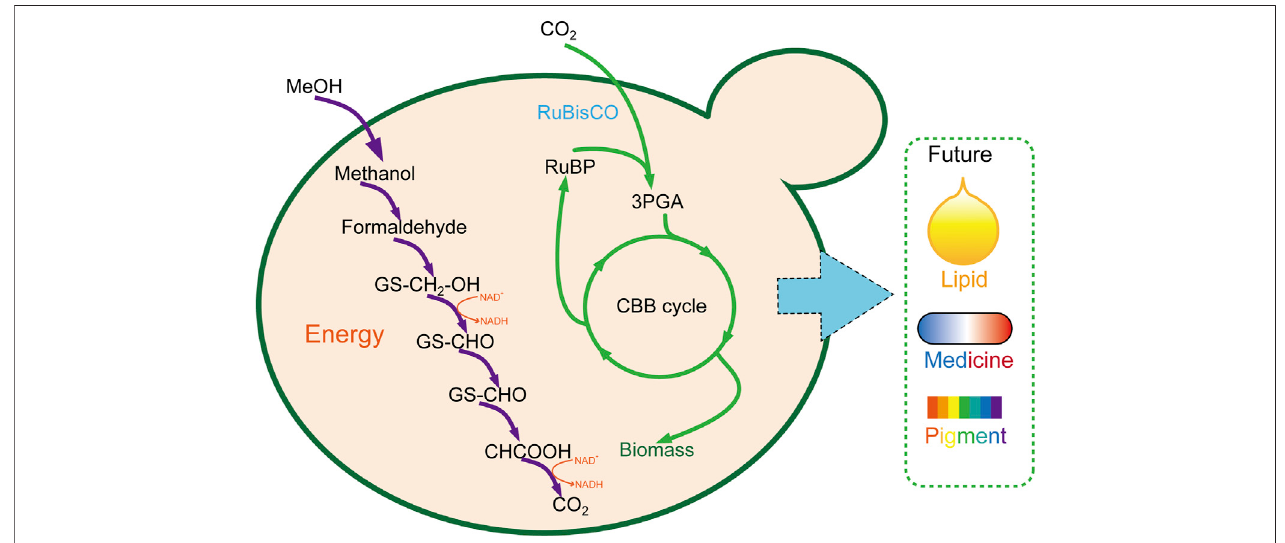
FIGURE 3 | Carbon fi xation in P. pastoris through the CBB cycle. 3PGA, glycerate 3-phosphate; CBB cycle, Calvin – Benson – Bassham